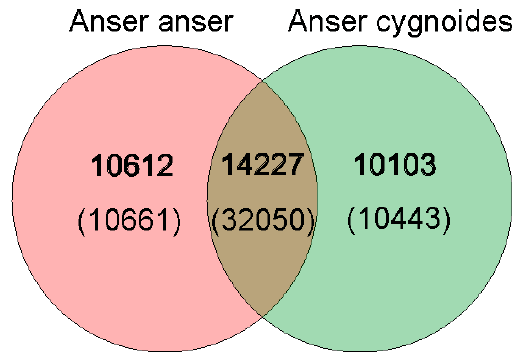
Figure 6. Gene families and genes obtained from the transcriptomes of Anser anser and Anser cygnoides . Gene families and genes were identified from the two transcriptomes using BLASTp and an OrthoMCL, with the total number of gene families and genes belonging to each species shown in the figure with 14,227 gene families and 32,050 genes conserved between the two species’ transcriptomes.